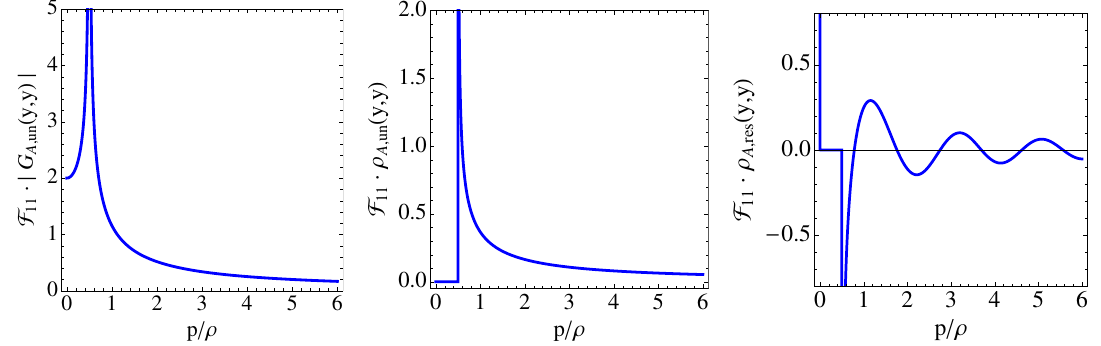
Figure 9 . Plots of the unparticle and resonant contributions to the Green’s function. We display the result for F 11 ·| G A, un ( y, y 0 ; p ) | (left panel), F 11 · ρ A, un ( y, y 0 ; p ) (middle panel) and F 11 · ρ A, res ( y, y 0 ; p ) (right panel), as functions of p/ρ . We have used y = y 0 = ( y 1 + y s ) / 2 and A 1 = 35 in all panels, and assume time-like momenta p 2 > 0